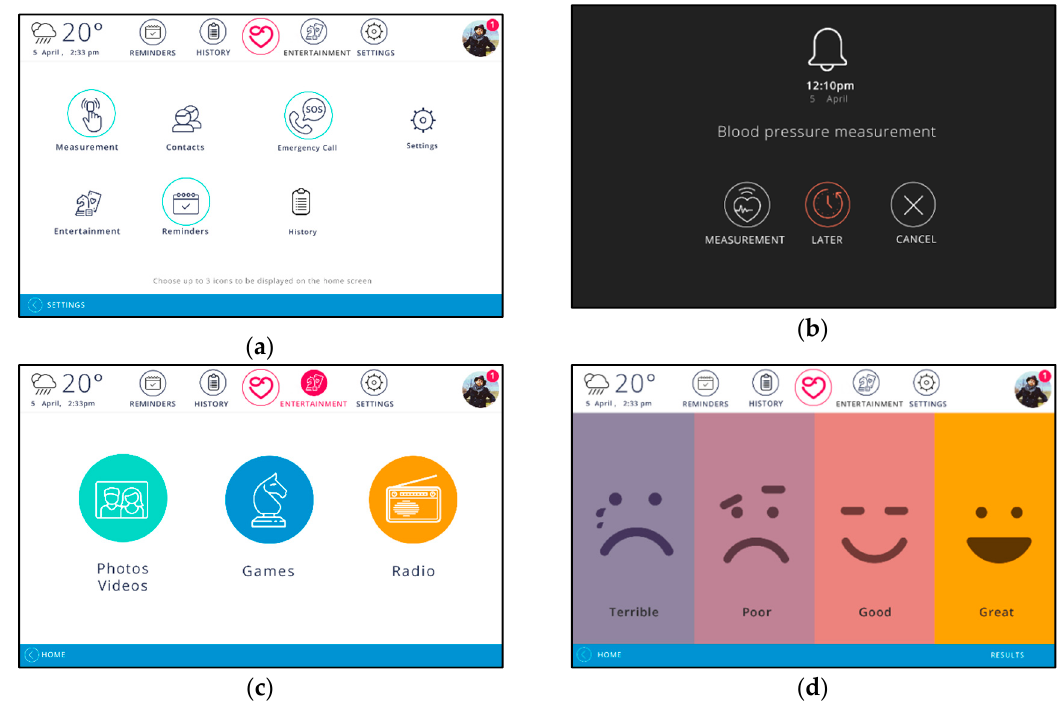
Figure 8. New GUI Views: ( a ) Home screen customization; ( b ) reminder notification; ( c ) entertainment menu and ( d ) daily wellness survey.